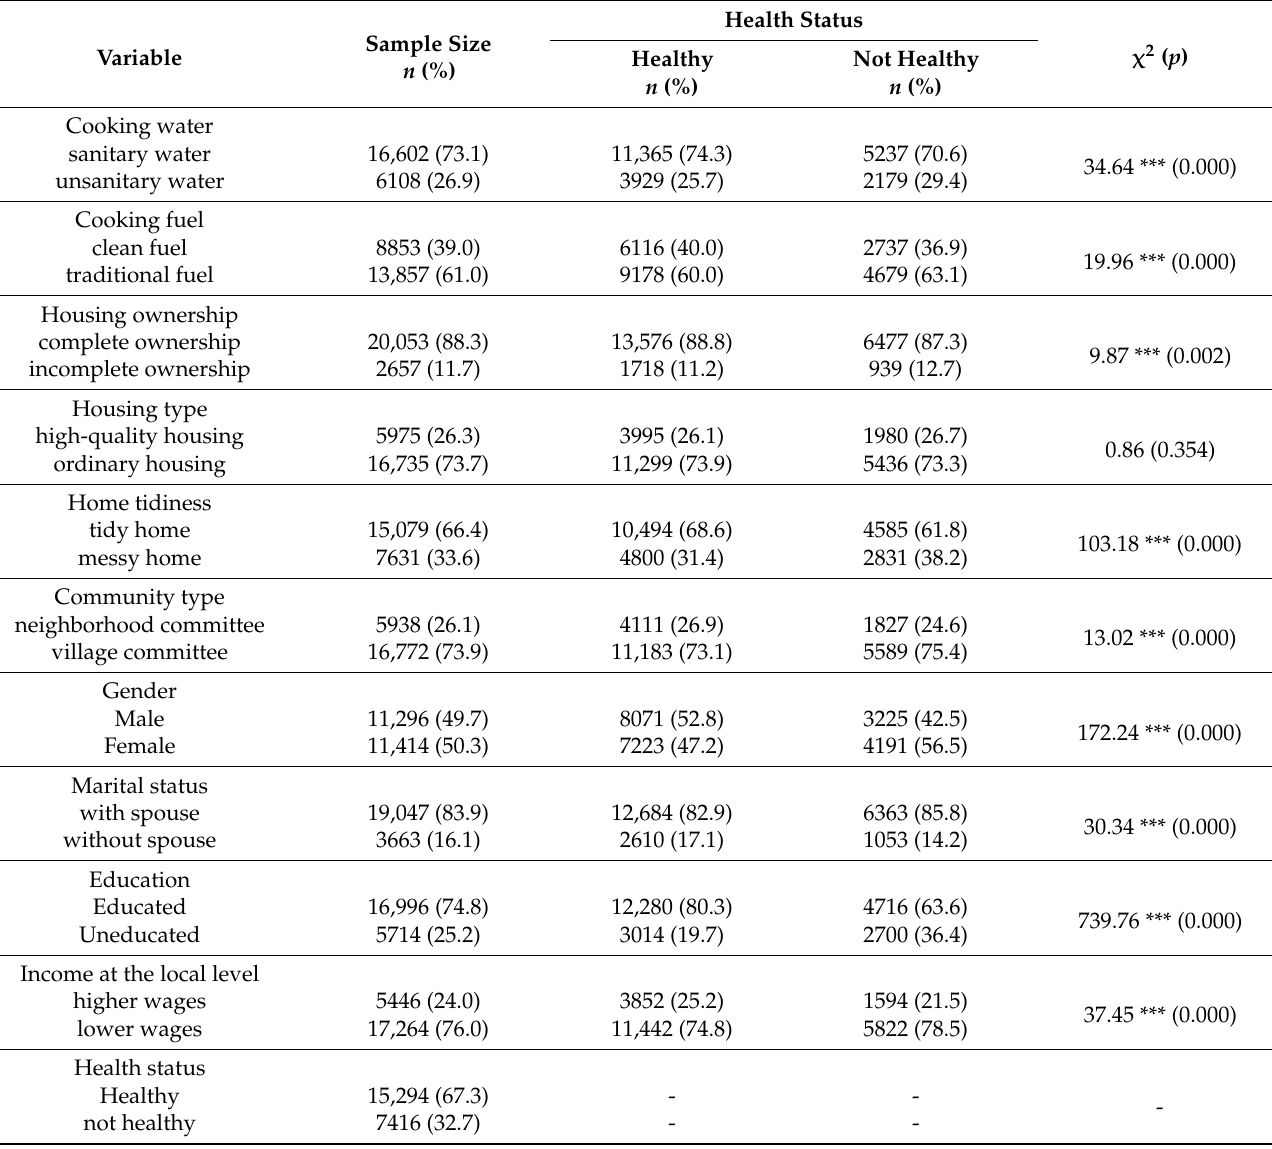
Table 2. Chi-square contingency table ( N =